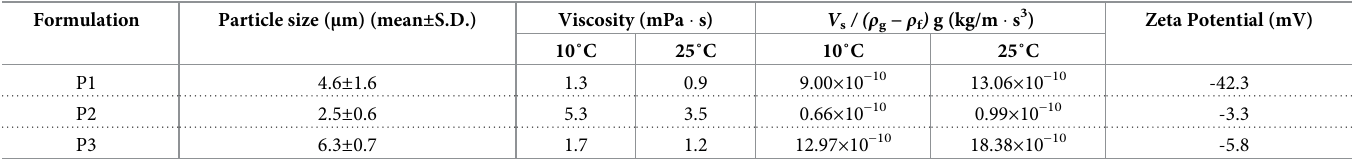
Table 2. Viscosity and zeta potential for 0.1% FLU ophthalmic suspensions used in this study. Formulation Particle size ( μ m) (mean ±